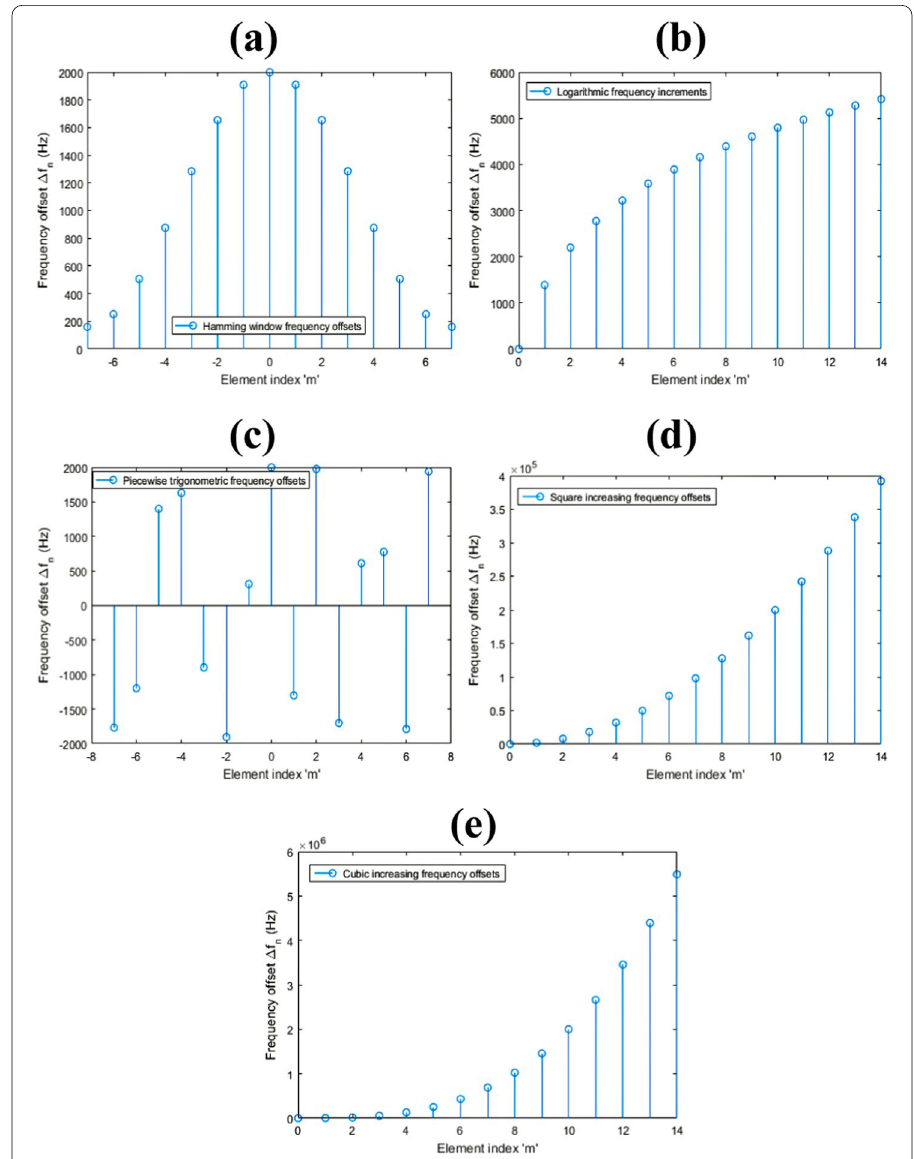
Fig. 7 Frequency offsets comparison. a Hamming window based frequency offsets. b Logarithmically increasing frequency offsets. c Piecewise trigonometric frequency offsets. d Square increasing frequency offsets. e Cubic increasing frequency